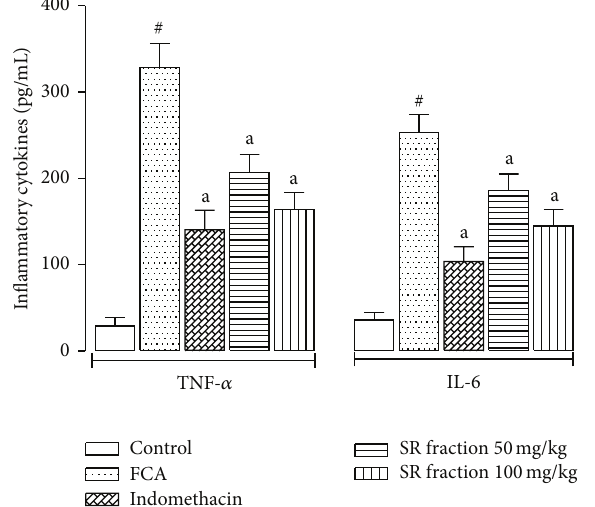
Figure 3: Effect of saponin rich (SR) fraction on inflammatory cytokines, namely, TNF- 𝛼 and IL-6 levels in plasma samples. Values are presented as mean ± SEM, 𝑛 = 6 . a 𝑃 < 0.05 compared with the FCA control group. # 𝑃 < 0.05 compared with vehicle